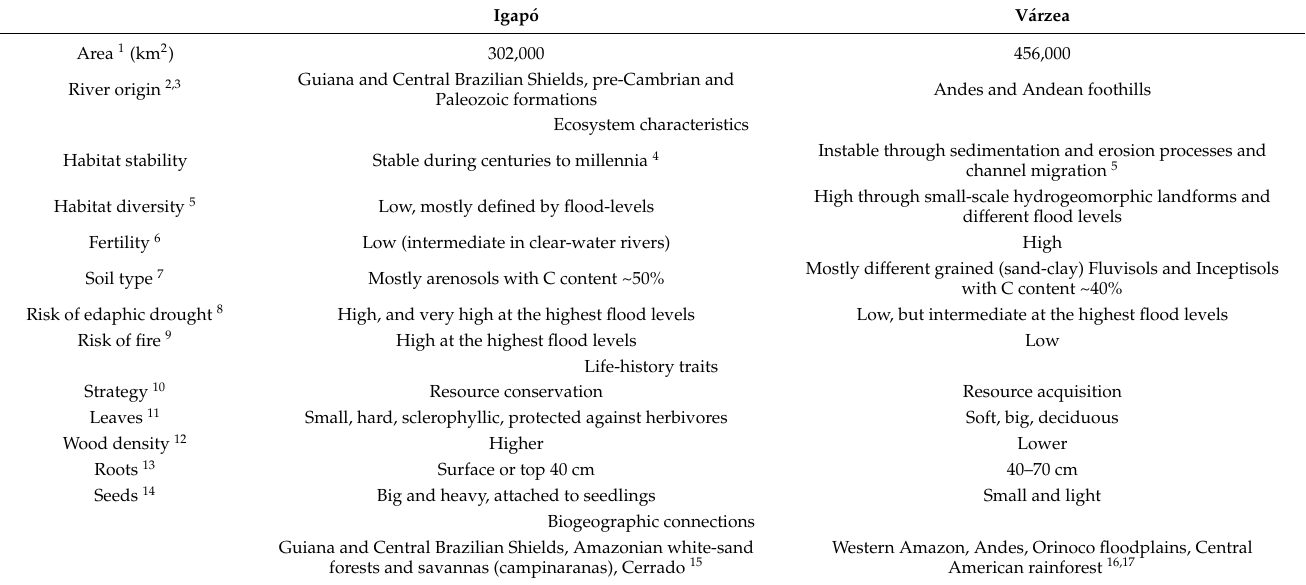
Table 4. Ecosystem characteristics of Amazonian igap ó and v á rzea floodplains, important life-history traits of colonizing tree species, and most important biogeographic connections to other